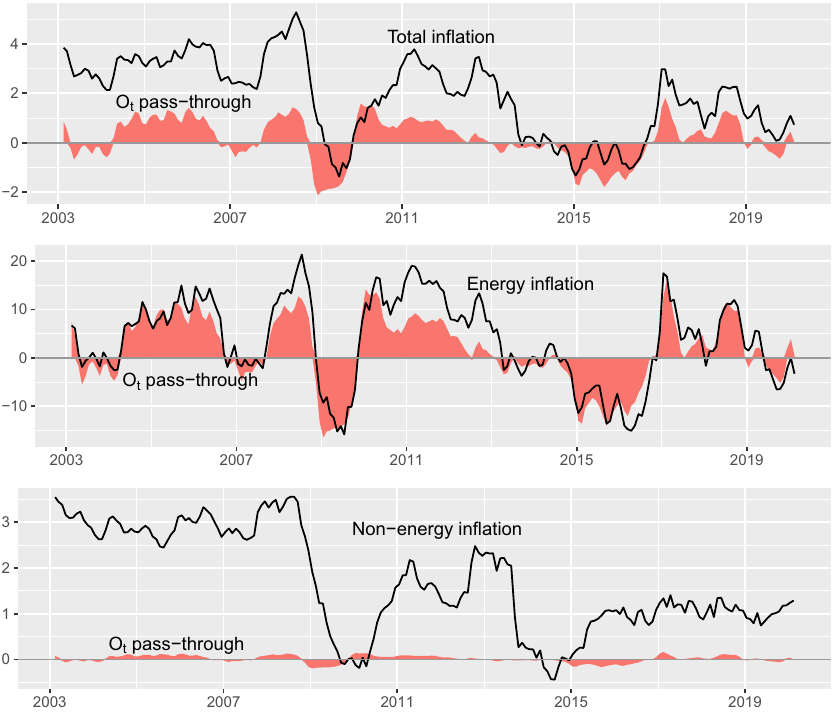
Fig. 5 12-Month percentage change of total, energy and non-energy CPI versus the estimated oil price pass-through. These series are standard (non-log) variation rates, Sample: 2003.02–2020.02